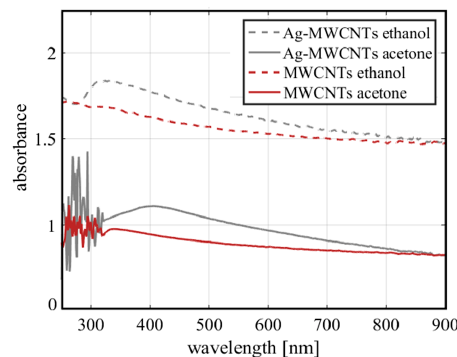
Figure 3. Typical UV-VIS absorption spectra of the studied nanofluids.